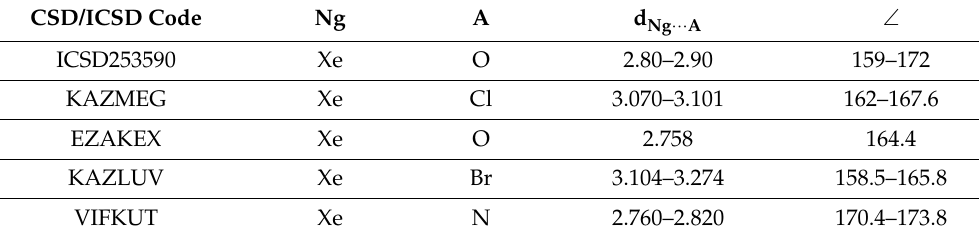
Figure 25. NgBs in the solid state of KAZLUV ( a ) and VIFKUT ( b ) structures. The NgBs are represented using dashed lines. H atoms omitted for clarity. Table 10. CSD codes, NgB donor (Ng) and acceptor (A) atoms, intermolecular distance (d Ng ··· A in Å), and X–HaB ··· A (X = O) angle ( ∠ in ◦